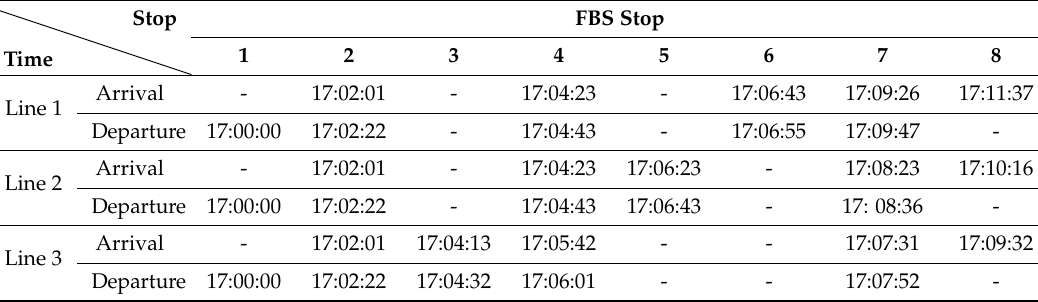
Table 4. Time stamps of FBS at each stop for the three lines illustrated as an example.